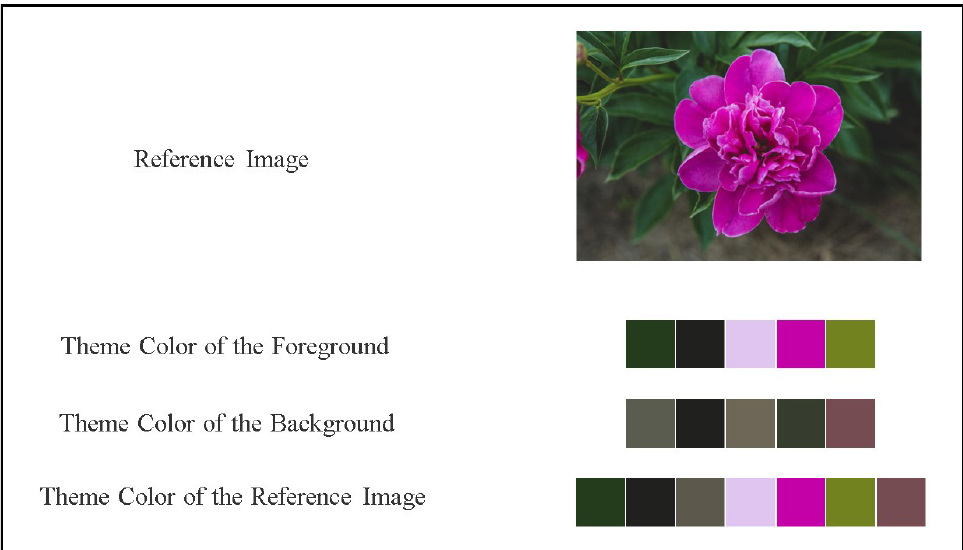
Figure 4. “5 + 2” color